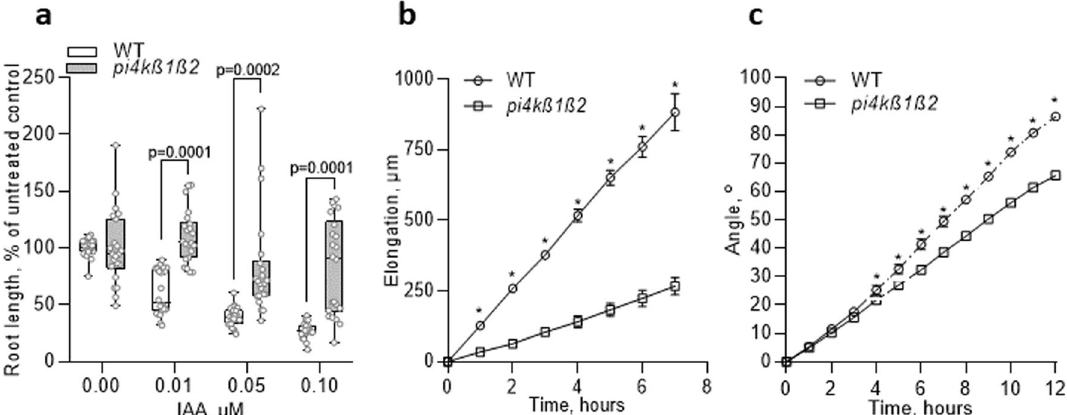
Figure 2. Auxin-related phenotypes of the pi4kß1ß2 mutant. ( a ) primary root length of 11-day-old seedlings in response to different IAA concentrations, n = 22. Central line of the boxplots represents the median, circles represent individual values; p -value is indicated for significantly different groups; t -test with correction for multiple comparisons; ( b ) Elongation rate of primary root under gravistimulation, n = 10; ( c ) root tip orientation angle, n = 10; ( b , c ) gravitropic assay, 5-day-old seedlings were rotated to 90° on a horizontal microscope, images were taken every hour. Asterisks indicate statistically significant differences between genotypes, p < 0.05, paired t -test with correction for unequal variances. Experiments were repeated three times; data from a representative repeat are